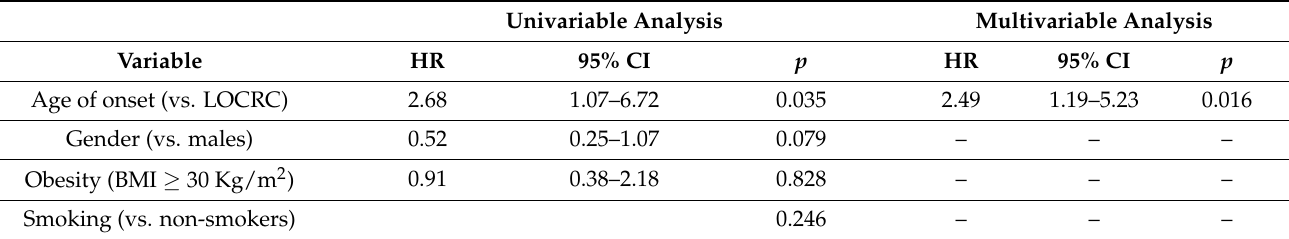
Table 6. Cox proportional hazard regression analysis on RFS of stage I patients.